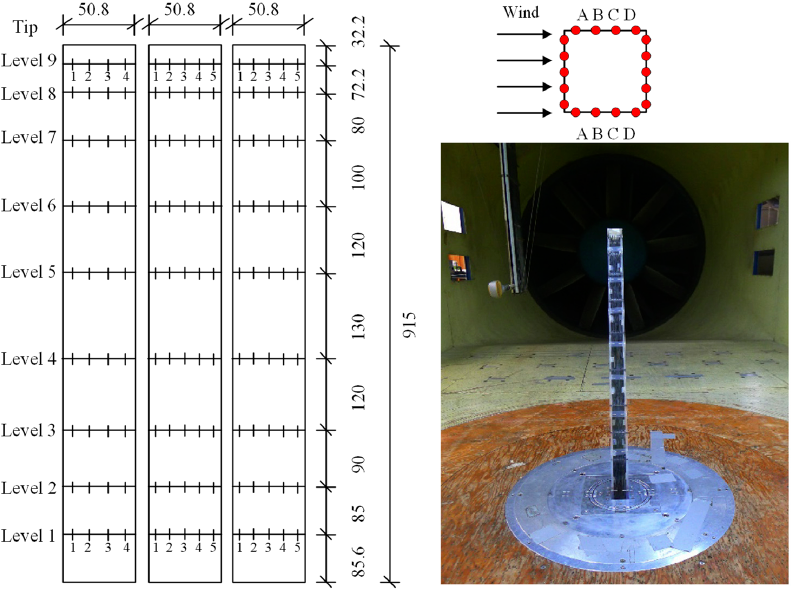
Figure 16. Distribution of the pressure sensors (units: mm) [30].